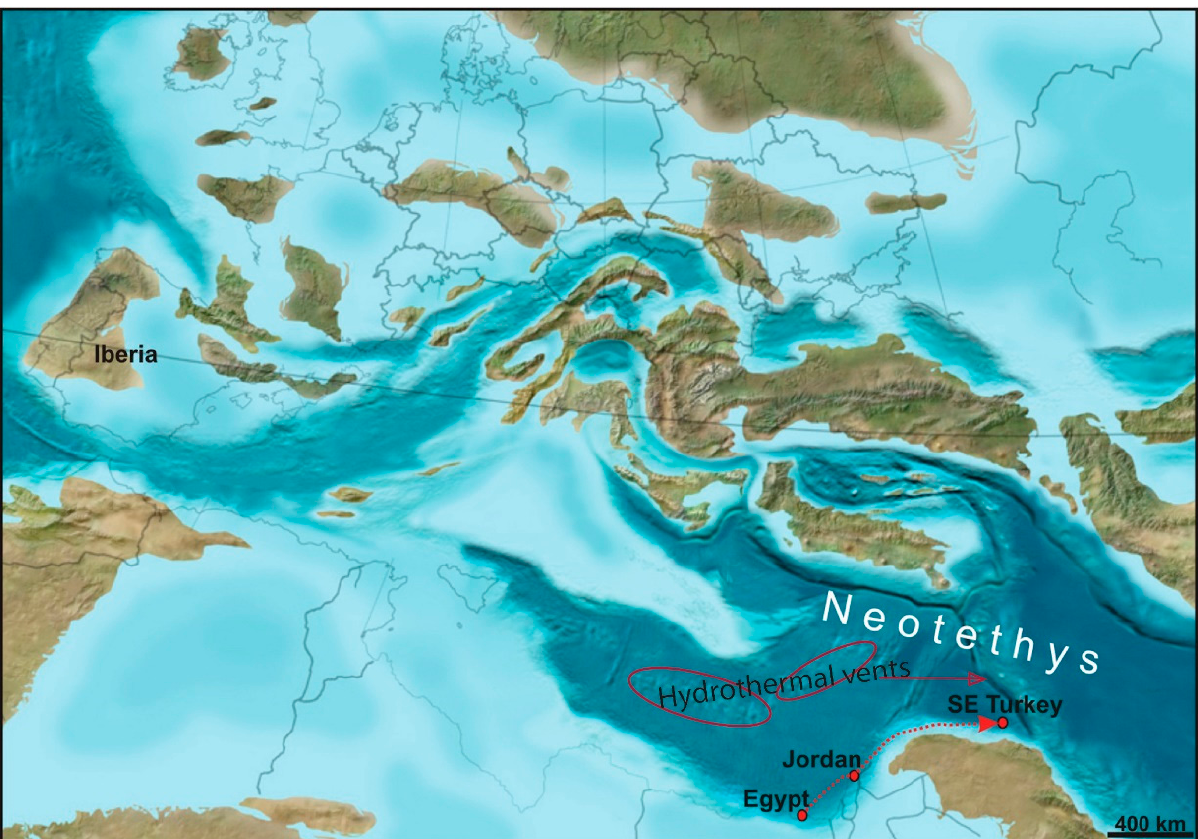
Figure 1. Paleogeographic map of the European, SE Turkey, and Middle Eastern regions in the Upper Cretaceous at 75 MA (modified from Ron Blakey, NAU Geolgy-http://www2.nau.edu/rcb7. Accessed on 1 January 2011). Data from [37].